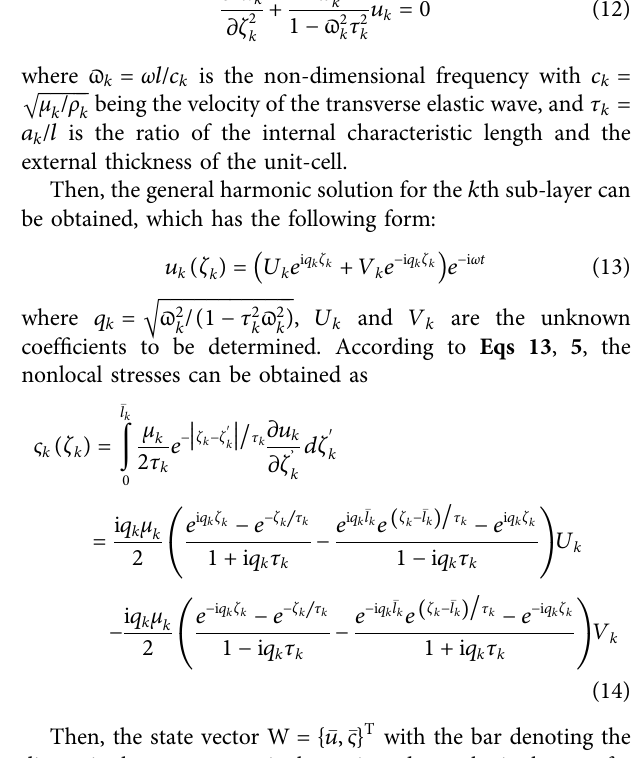
Frontiers in Materials |